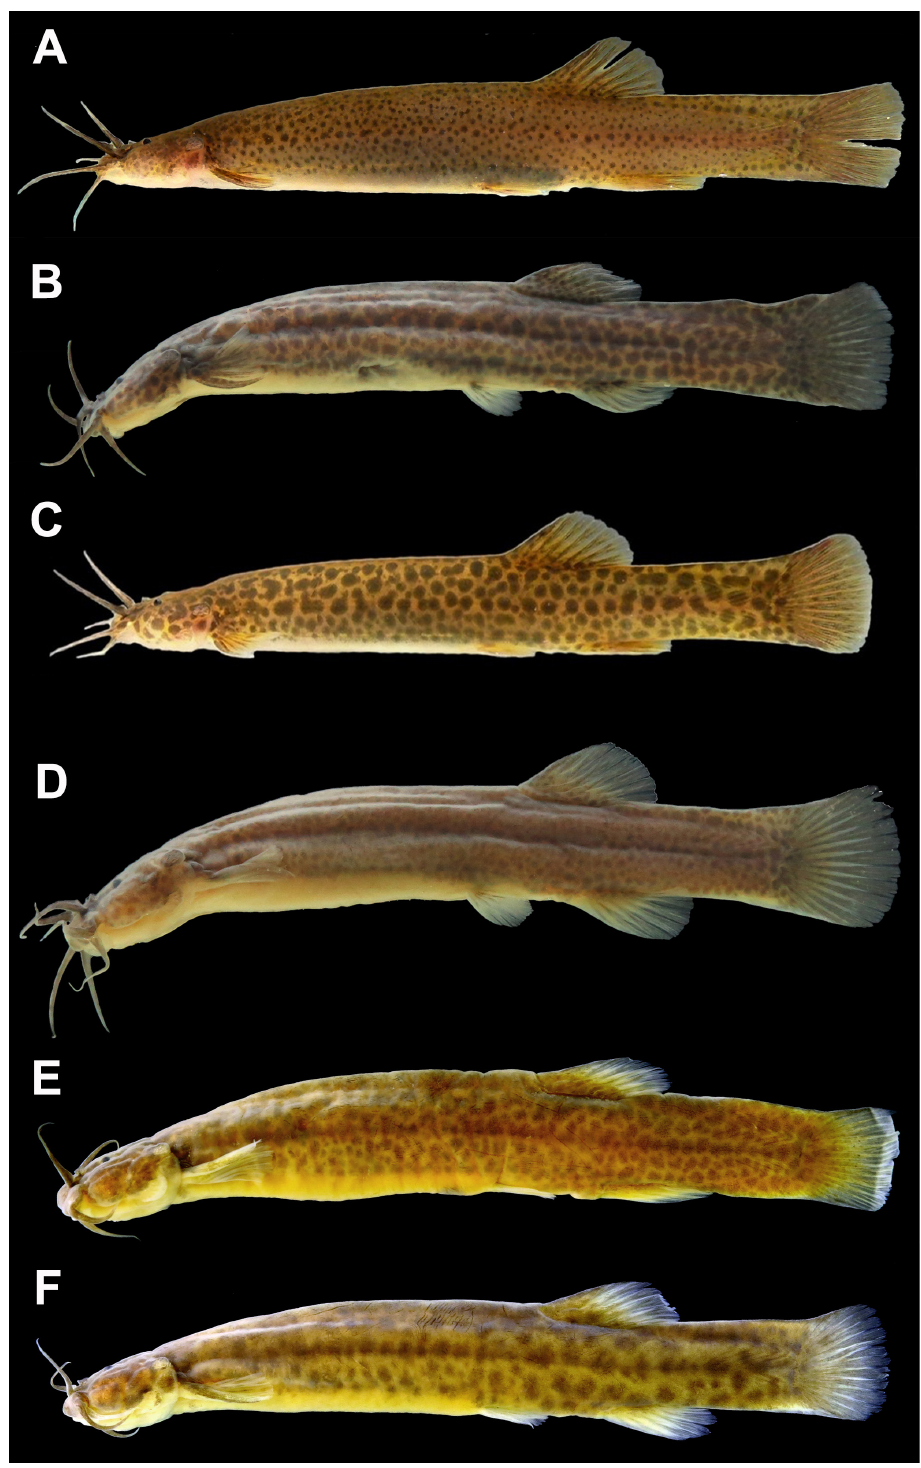
FIGURE 10 | Variation on the coloration of Cambeva sp. 2 from ( A–D ) Tubarão River, UFRGS 24553, 66.1, 45.4, and 56.04, 52.1 mm SL, and ( E, F ) Araranguá River, UFRGS 22964, 61.1 and 60.7 mm SL, respectively, showing a unique color pattern that differs from other congeners in the study area: one layer of coloration composed of not coalescent round small